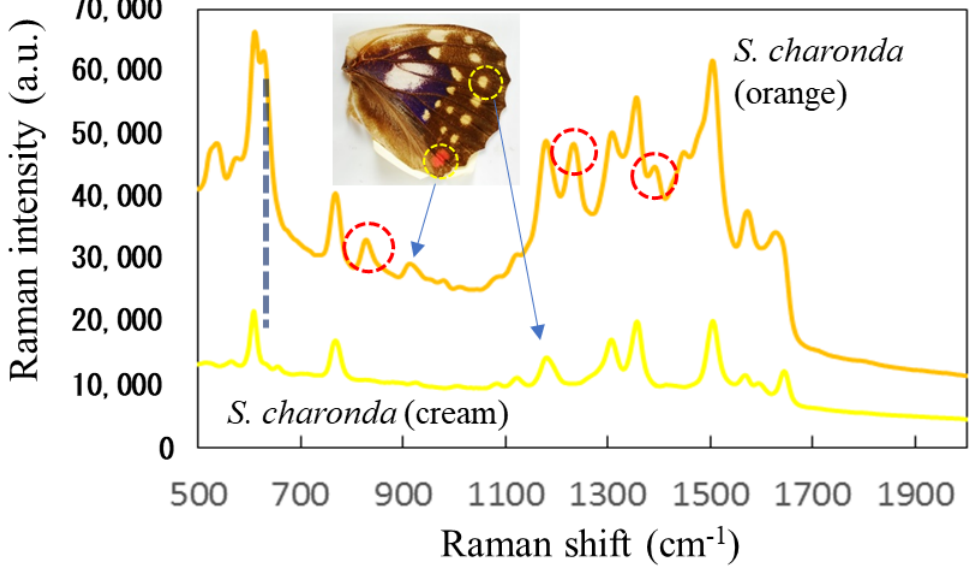
Figure A9. SERS spectra of 1 mM R6G from an orange and a cream scales of S. charonda . Bands unique to the orange scale are circled.